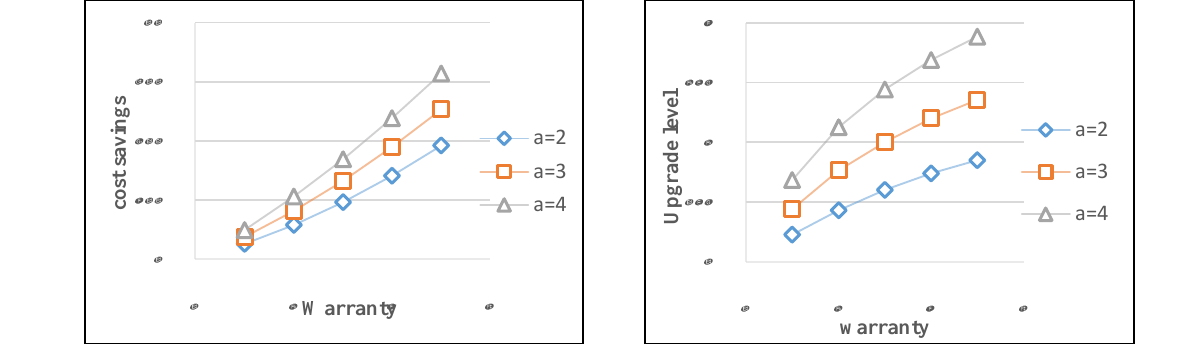
Fig. 1. Average savings of upgrade action. Fig. 2. Optimum upgrade levels in different